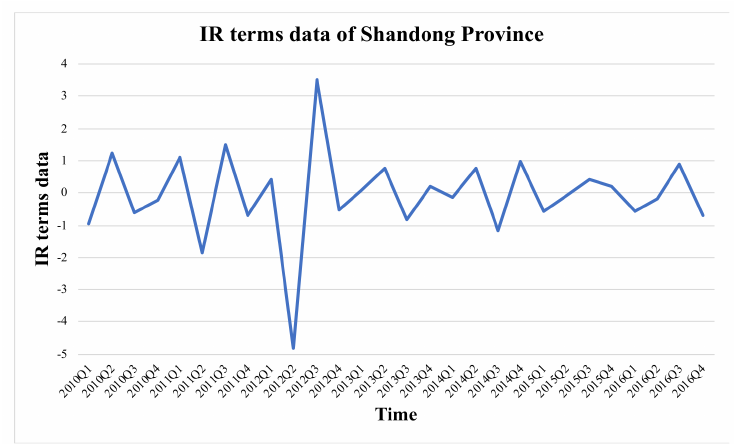
Figure 15. IR terms data of Shandong Province.